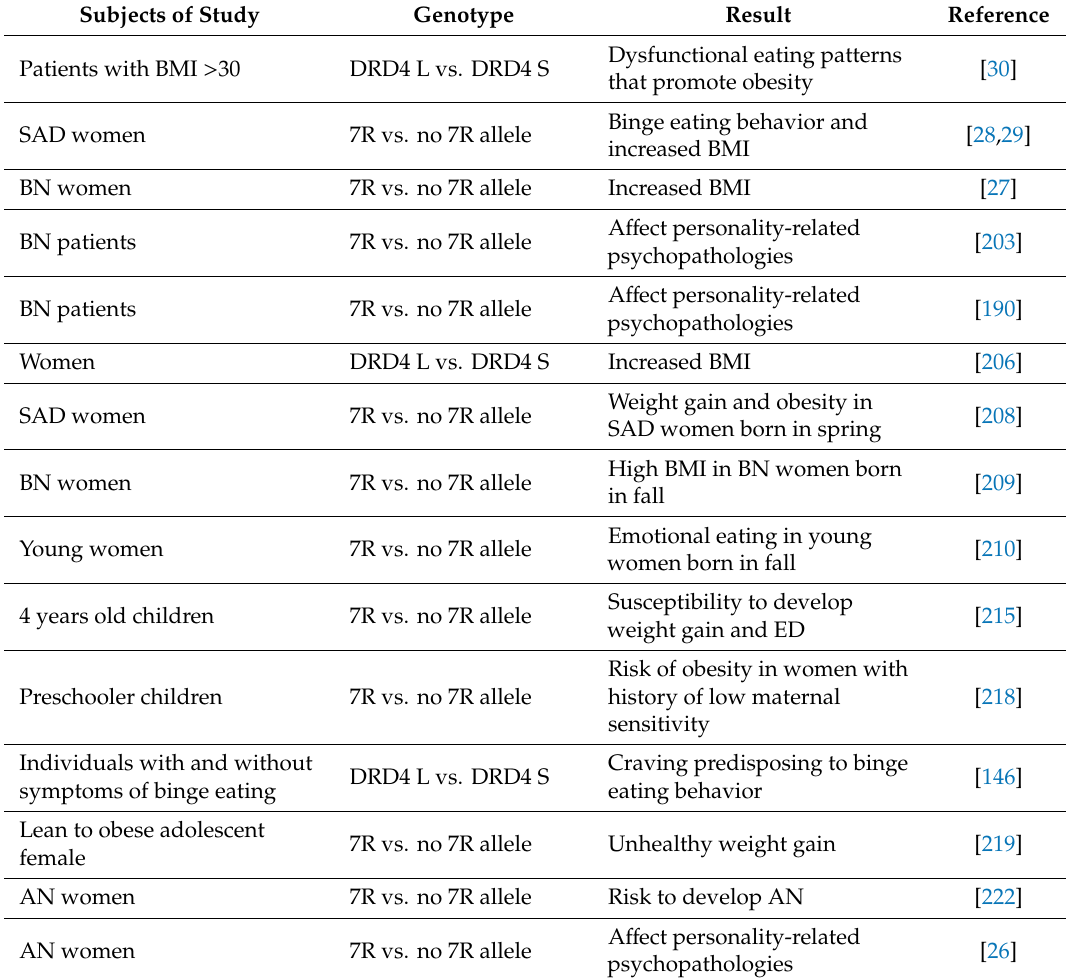
Table 2. The e ff ect of the 7R or longer allele (DRD4 L) in eating